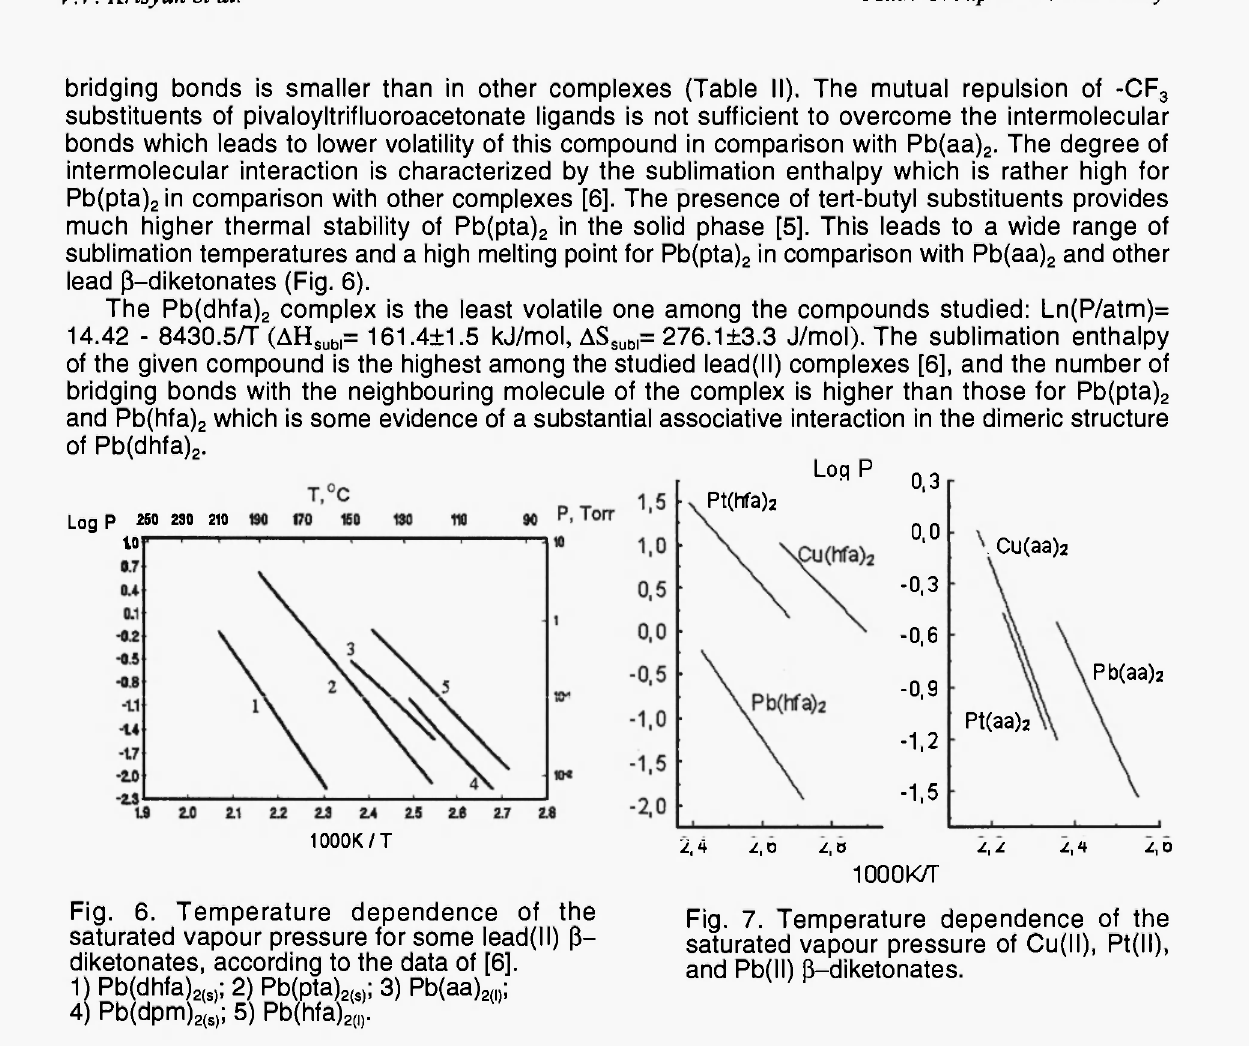
Fig. 6. Temperature dependence of the saturated vapour pressure for some lead(ll) β- diketonates, according to the data of [6], 1) Pb(dhfa) 2(s) ; 2) Pb(pta) 2( „; 3) Pb(aa) 2(l) ; 4) Pb(dpm) 2(s) ; 5) Pb(hfa) 2(l) .